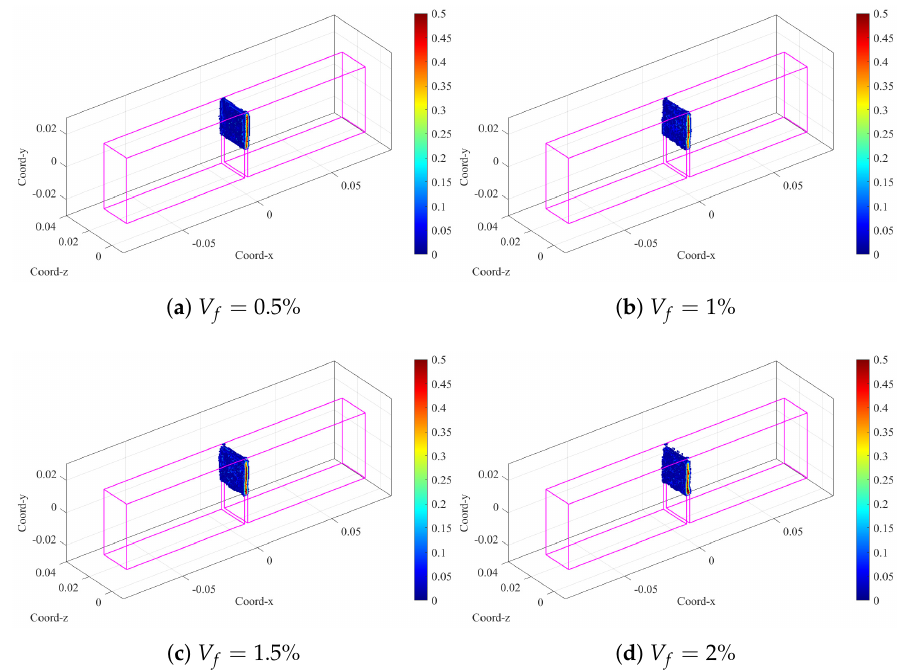
Figure A1. Damage levels in the simulated UHPC-PVA beam specimens with C l = 0